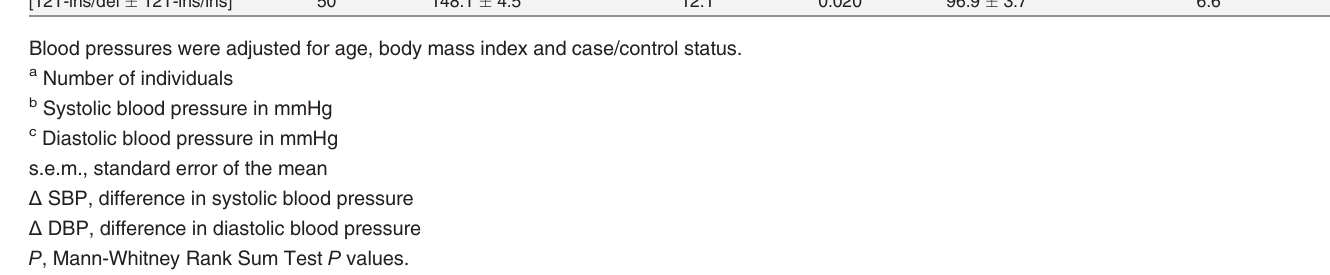
compared to age-matched littermate wild-type ATP1A1 +/+ male mice on regular mouse chow. Analysis of ATP1A1 protein levels by western blot analysis revealed that heterozygous ATP1A1 +/ − knockout male mice expressed 58% less ATP1A1 protein levels in kidney (Fig. 2A-2B) compared to wild type mice, as expected from haploinsufficiency. These data are concordant with decreased ATP1A1 levels in the heart of non-inbred ATP1A1 +/ − heterozygous knockout mice [20].